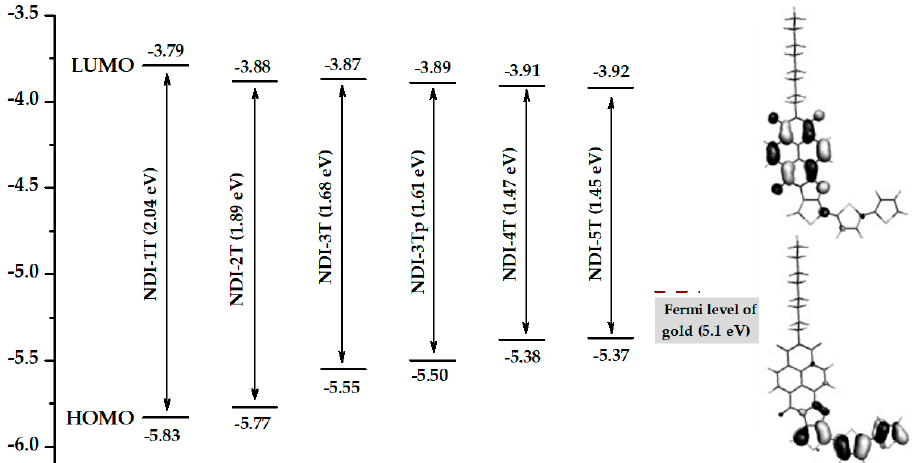
Figure 6. Left: HOMO/LUMO energy levels derived from the electrochemical measurements. Energy gaps are shown in brackets. Right: DFT/B3LYP/6-31G** LUMO ( top ) and HOMO ( bottom ) orbital molecular topologies of NDI-3Tp . Reproduced with permission from Chem. Eur. J . 2012 , 18 , 532–543. Copyright© 2012 WILEY-VCH Verlag GmbH & Co. KGaA, Weinheim, Germany [20].